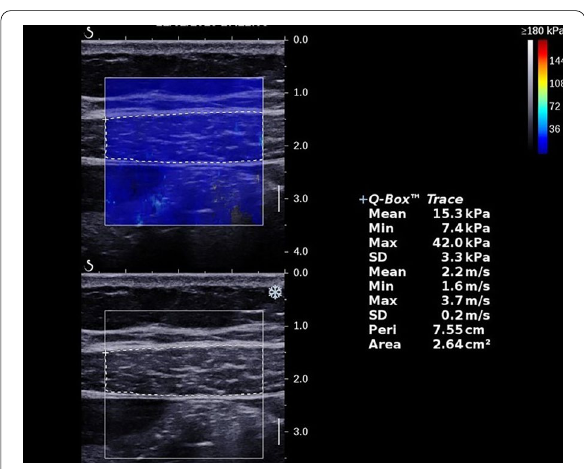
Fig. 4 Ultrasound images of shear wave speed measurement in upper right rectus abdominis. A new region of interest (dotted line) was drawn to obtain the parameter of mean shear wave speed